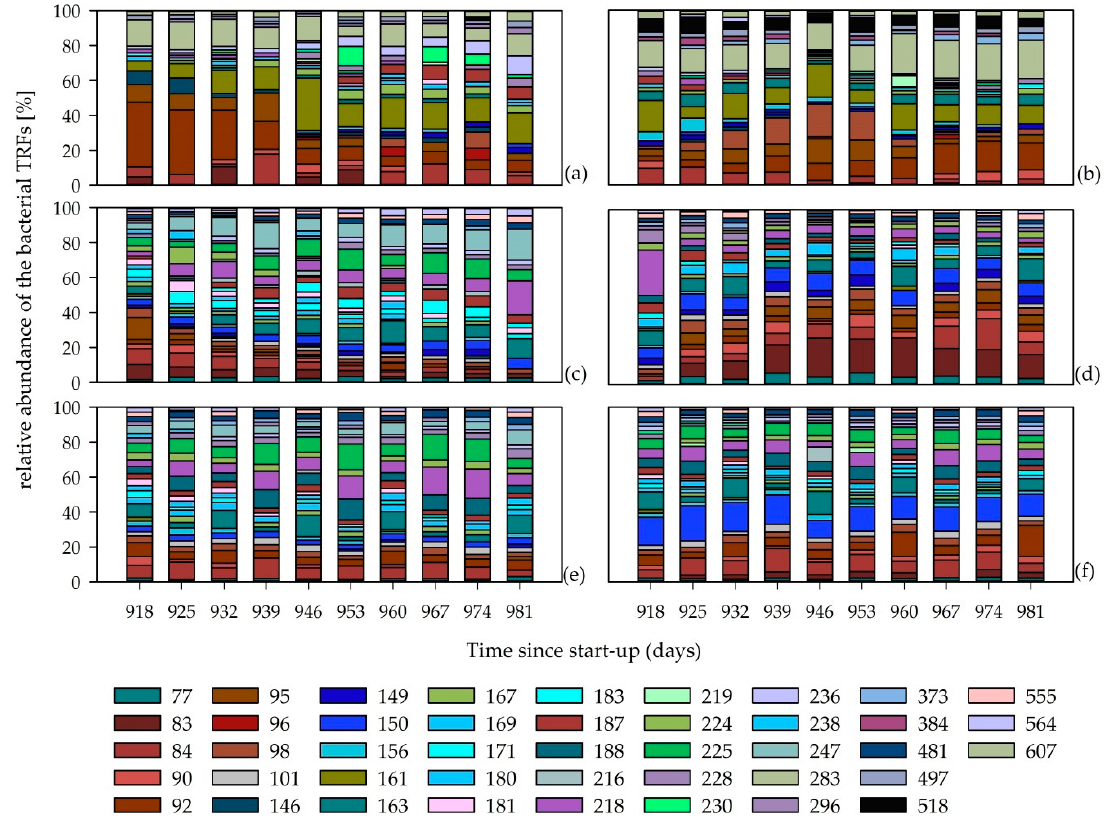
Figure 2. Structure of the bacterial community in reactors SB-M1 ( a ), M-SB1 ( b ), SB-M2 ( c ), M-SB2 ( d ), SB-M3 ( e ), and M-SB3 ( f ). Colored bars symbolize the detected terminal restriction fragments (TRFs) in base pairs (bp) and their relative abundance. For the bacterial community, only TRFs with a relative abundance over 3% in at least one sample are shown. Each sampling point is given as a median value of three technical replicates. Numbers in sampling point descriptors indicate the duration of continuous fermentation in days since start-up.